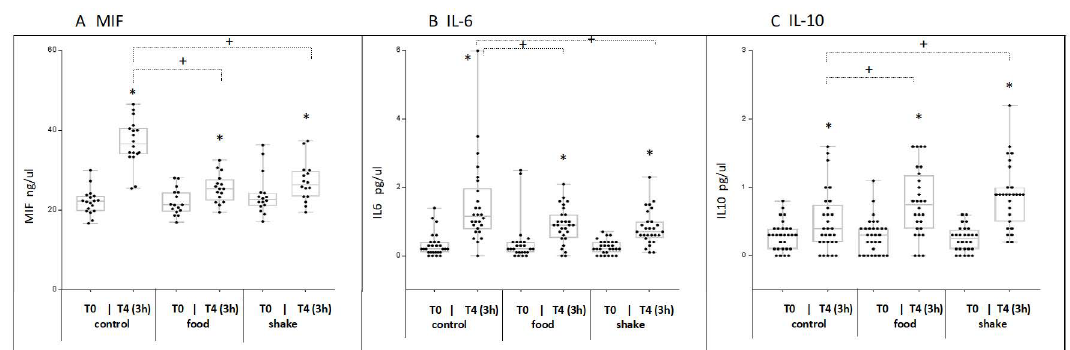
Figure 4. Effects of protein/carbohydrate uptake via food and shake, immediately after exercise, on serum levels of MIF ( A ) IL 6 ( B ) IL 10 ( C ) and 3h after exercise (t4; +180 min)). Shown are mean individual serum concentrations of the respective cytokines (A, B, C). Shown is mean ± SD. * = p ≤ 0.05, statistically significant differences between marked time point and respective t0 value. + = p ≤ 0.05 show statistically significant differences between marked